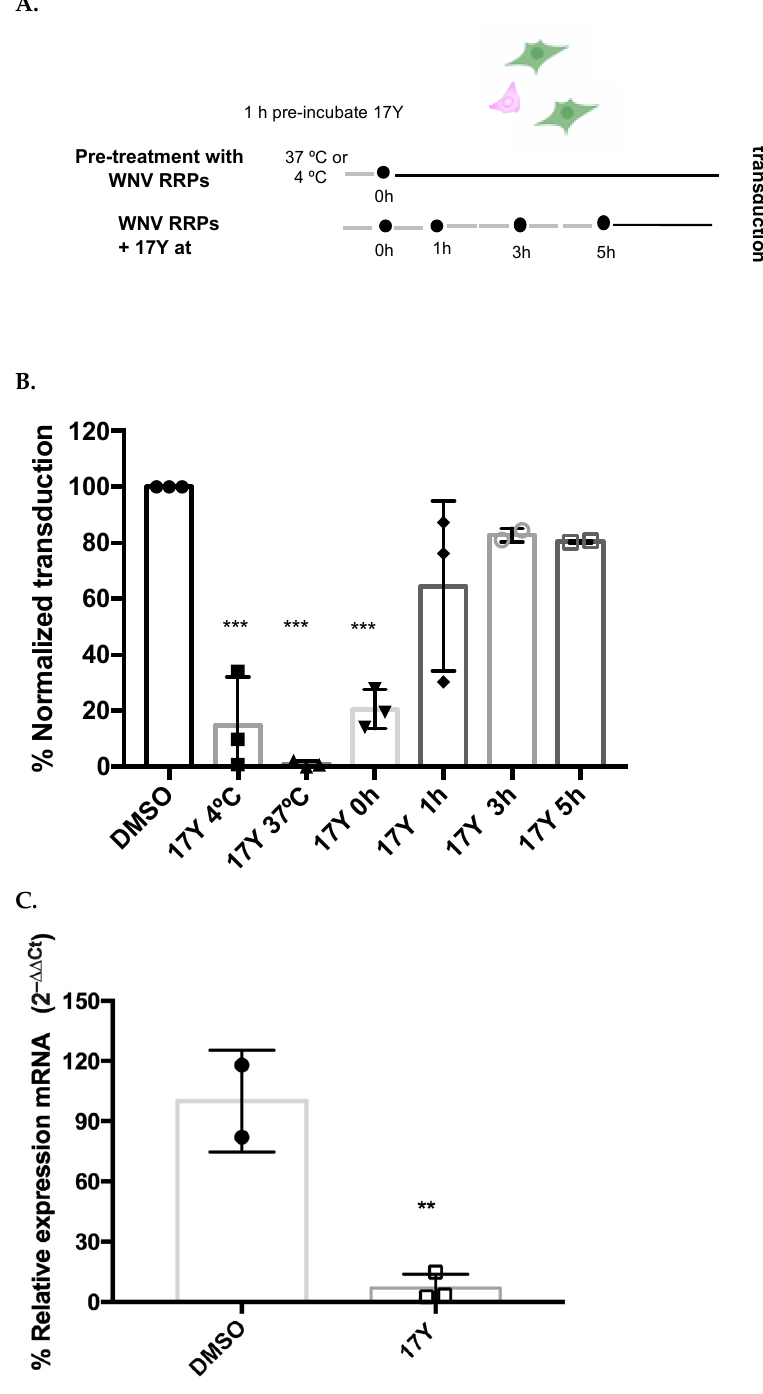
Figure 2. 17Y inhibits WNV RRPs’ transduction acting before attachment. ( A ) Scheme of the experimental design to study the effect of 17Y at different stages of RRP transduction. ( B ) RRPs were pre-incubated for 1 h with 17Y (10 µM) at 4 °C (Lane 2) or 37 °C (Lane 3) before transduction. Alternatively, the compound was supplemented in the medium after 0, 1, 3 or 5 h following transduction (Lanes 4–5-6–7). Negative control was treated with vehicle DMSO (Lane 1). ( C ) RRPs were pre-incubated with 17Y (10 µM) or DMSO for 1 h before administration to the cells at 4 °C for 90 min. Attached viral particles were evaluated by RT-qPCR (WNV sequences) using the